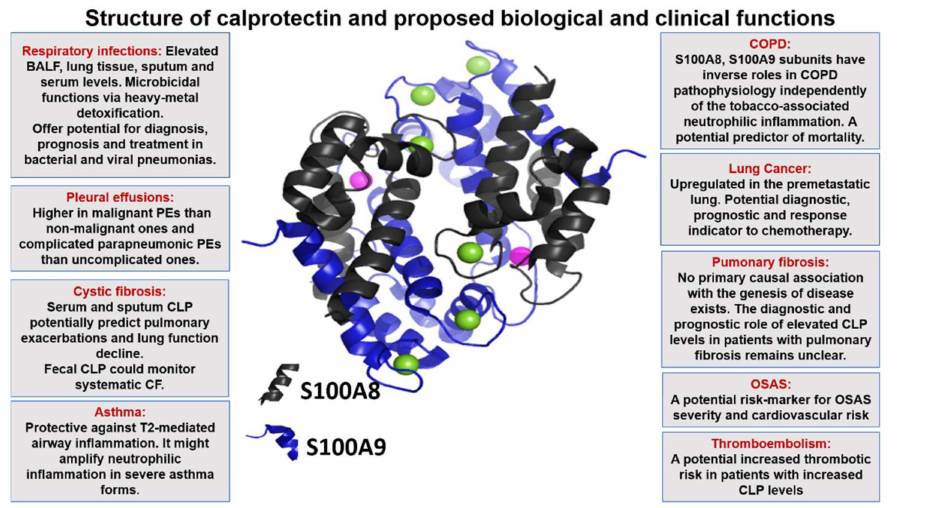
Figure 1. Crystal structure of calprotectin and proposed functions as regards to respiratory